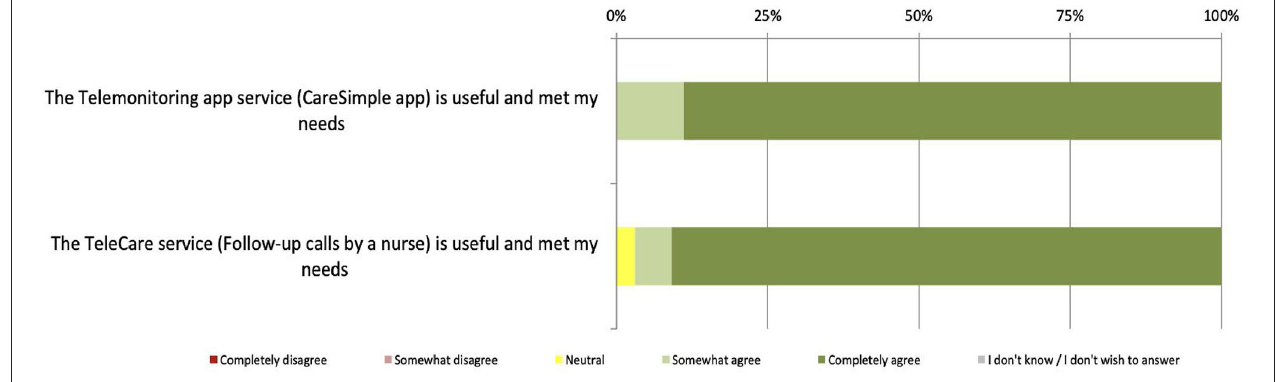
FIGURE 3 | Perception of the usefulness and usability of the